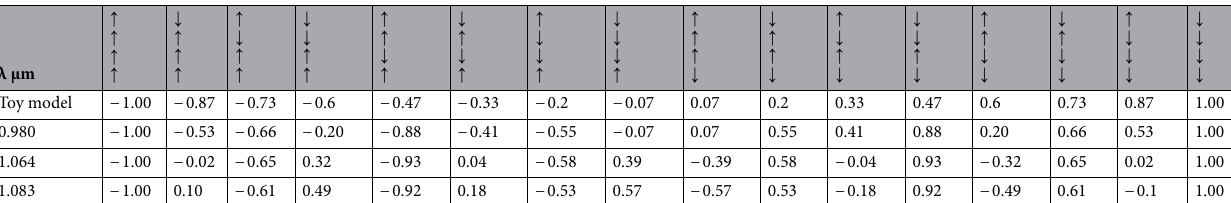
Table 5. The total Faraday rotation observed in the MPC with different magnetization states schematically shown by arrows at three wavelengths of 0.98um, 1.064um, and 1.083um and for a toy